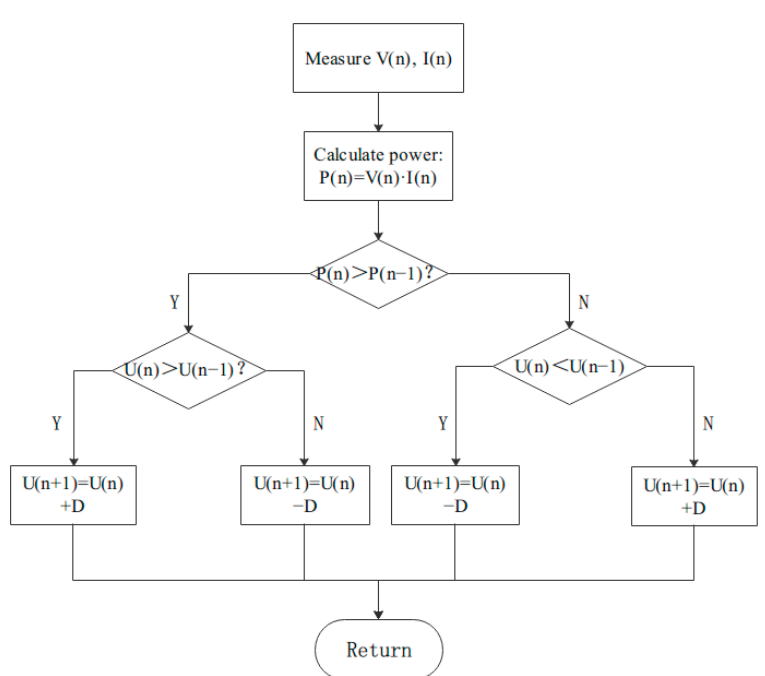
Figure 10. The flowchart of the P&O MPPT algorithm.